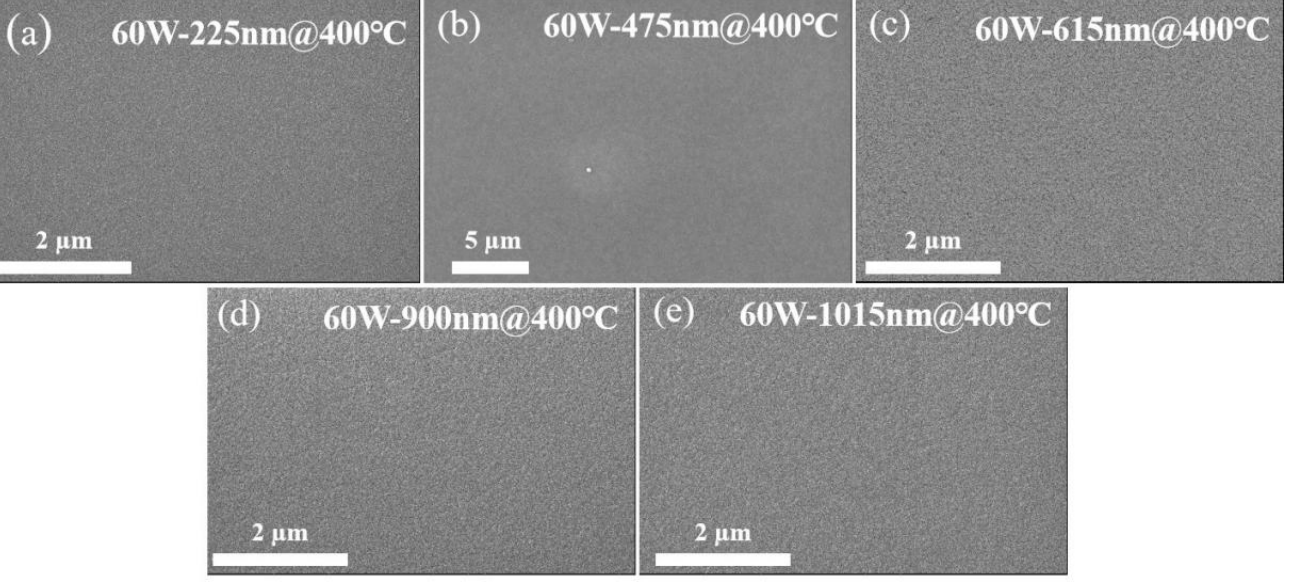
Figure 6. ( a – e ) are the SEM images of Y 2 O 3 films (samples 2-1 to 2-5) annealed at 400 °C.